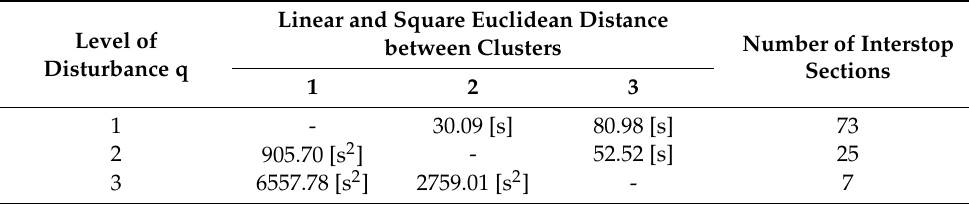
Table 2. Distances between clusters and number of included interstop sections. Linear and Square Euclidean Distance Level of between Clusters Number of Disturbance q